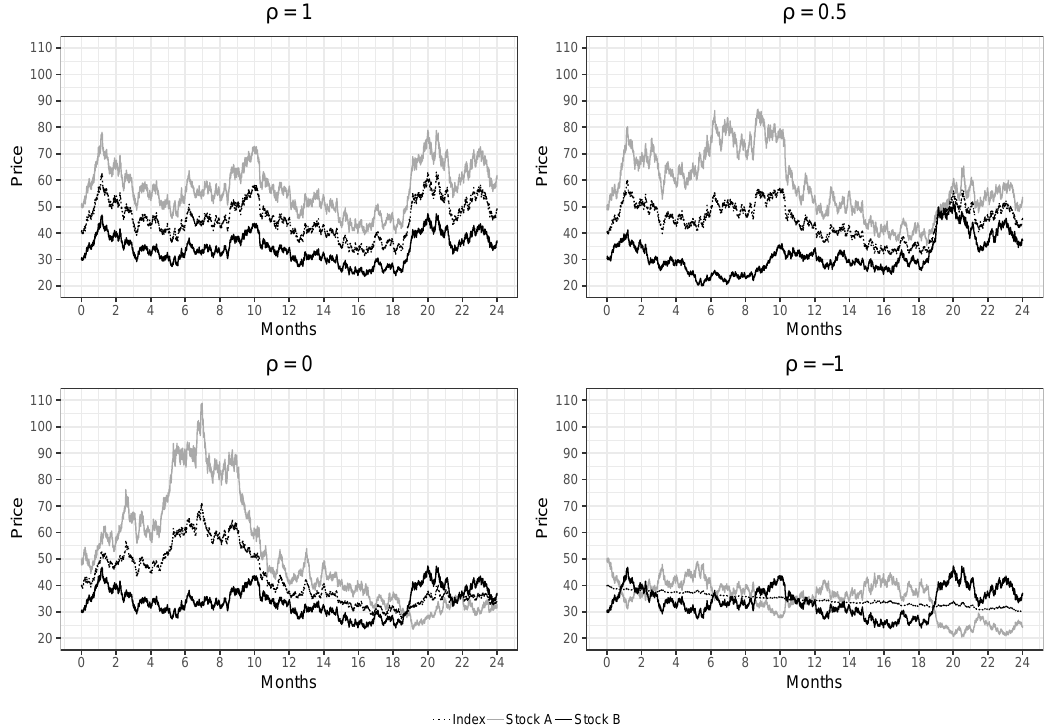
Figure 2. Illustration of the effect of different correlation levels on the variance of an equally weighted index of two stocks. Source: authors’